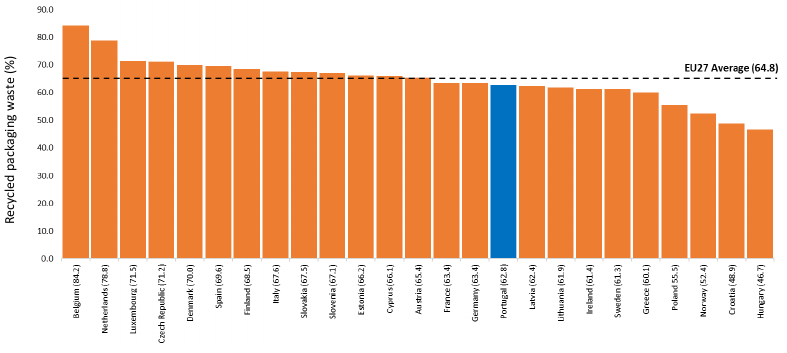
Figure 2. Recycling rate of packaging waste for 2019 [31].